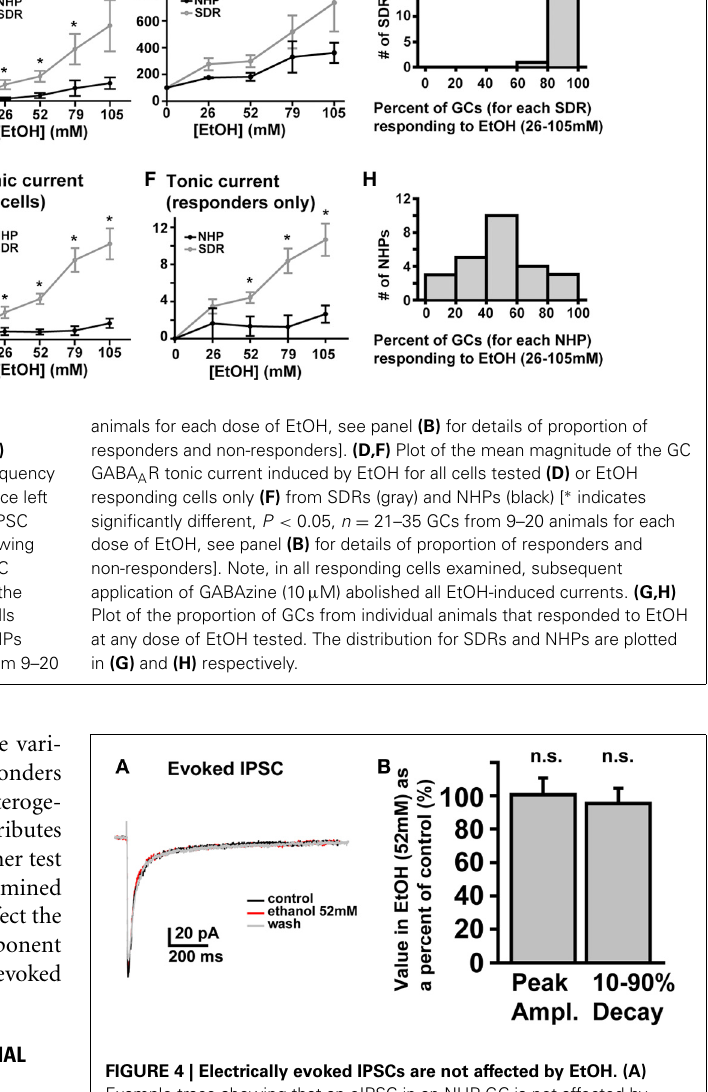
4.35 ± 0.60 pA in non-responding NHP and SDR GCs respec- tively, which corresponded to 38.45 ± 4.05 and 16.18 ±